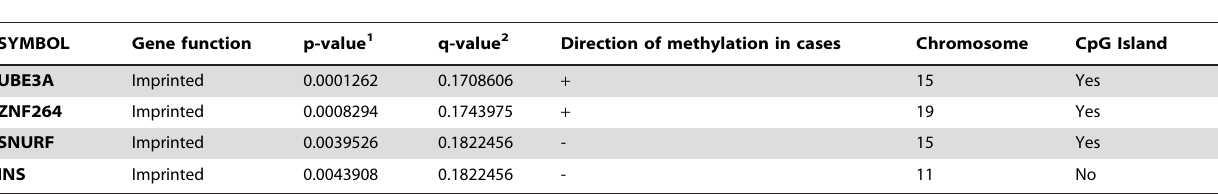
Table 3. Differentially methylated imprinted